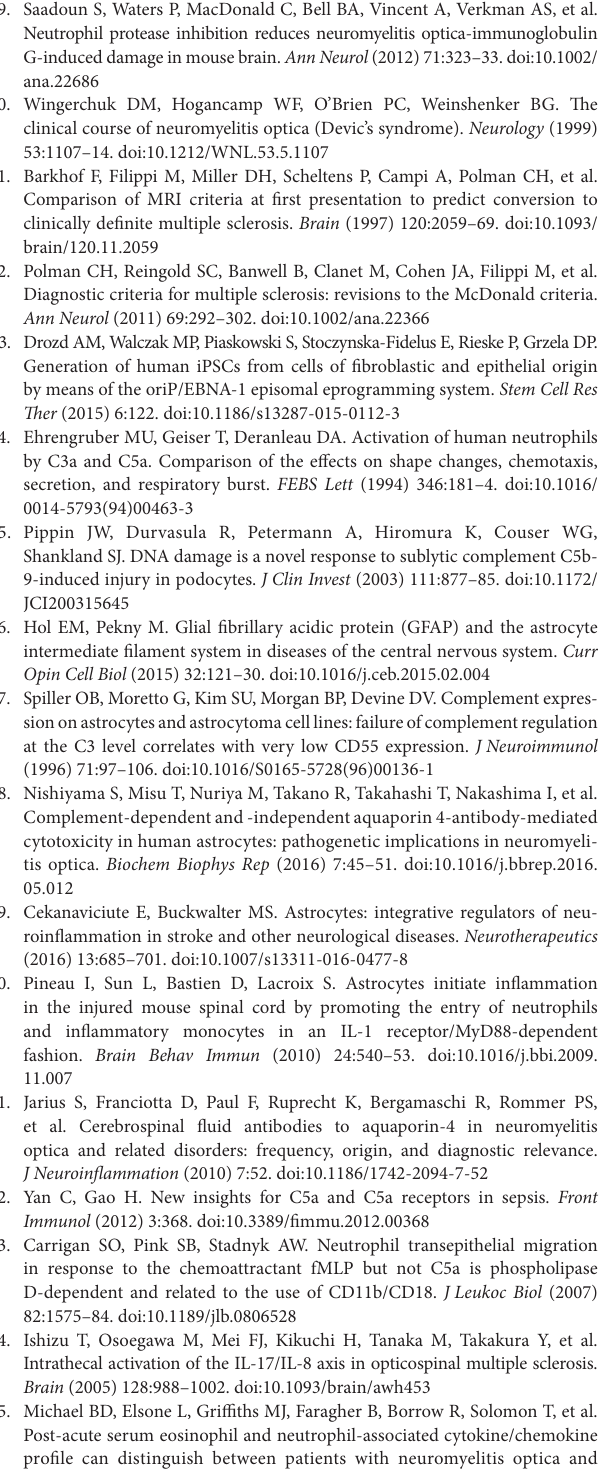
Table s1 | C5a-preactivated healthy control (HC) neutrophils polarize astrocytes into proinflammatory cells. Statistically significant differences between (a) astrocytes vs. astrocytes + neuromyelitis optica spectrum disorder (NMOSD) serum and (b) astrocytes + NMOSD serum vs. astrocytes + NMOSD serum + HC neutrophils. Data are presented as the means ± SEM from four independent